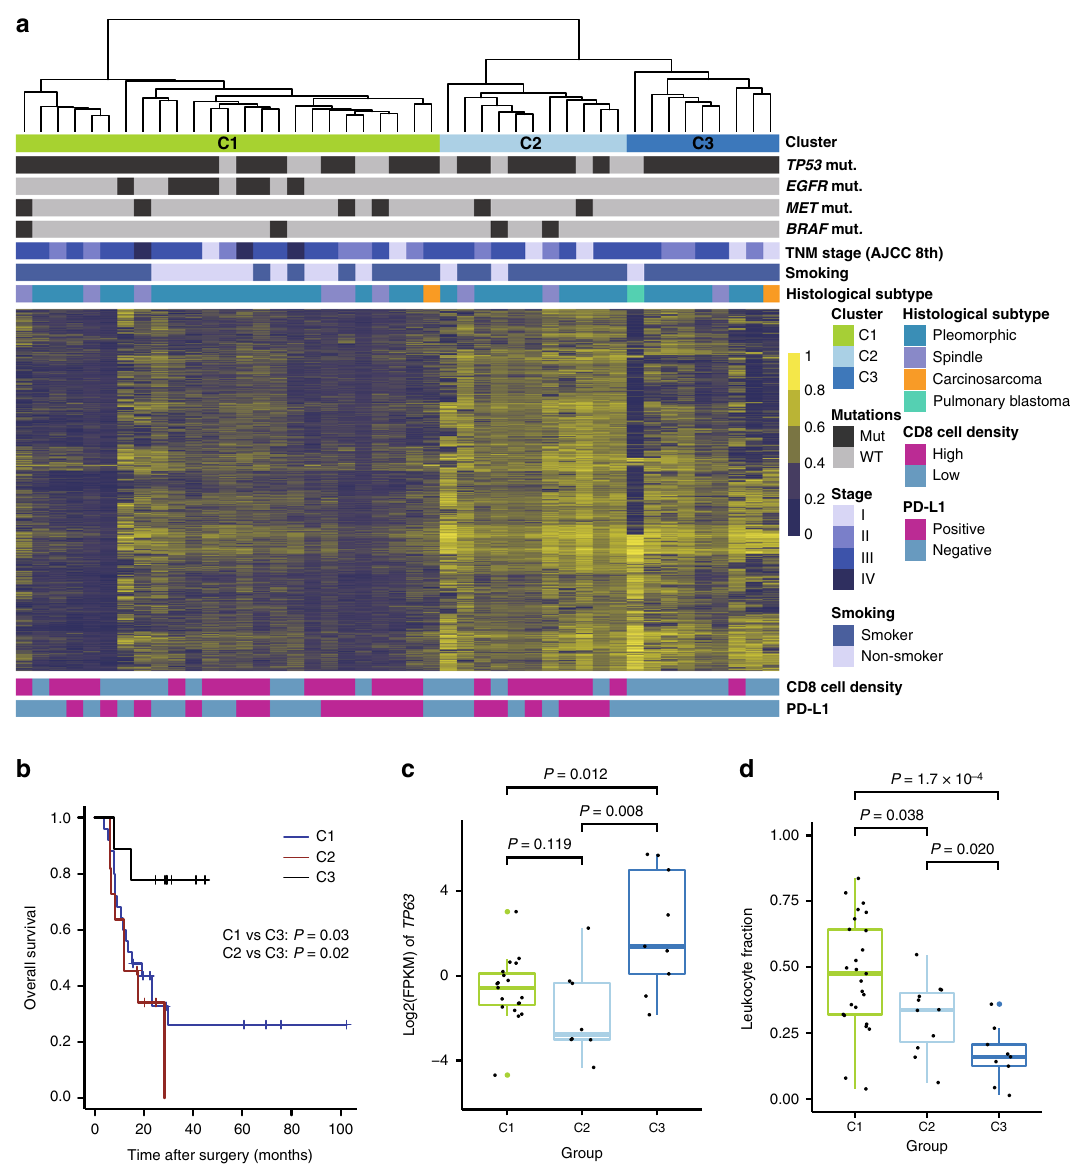
Fig. 5 Integrated molecular classi fi cation of PSC. a PSC tumors are classi fi ed into subgroups based on DNA methylation patterns, annotated for the mutation status (Mut, mutated; WT, wild-type) of important genes, TNM stage, smoking status, and histological subtype in the top panel and for the immunohistochemical analysis of PD-L1 and CD8 in the bottom panel. b Kaplan – Meier analysis of C1, C2, and C3. The signi fi cance is determined by log- rank test. c Boxplot shows the expression level of TP63 for three clusters. d Leukocyte fraction of each sample for three clusters are plotted as boxplots. Center line, median; box limits, upper and lower quartiles; whiskers, 1.5× interquartile range; colored points, outliers. Two-sided Wilcoxon rank-sum test was used for statistical analysis of ( c ) and ( d ). No P -value adjustment was applied. PD-L1, programmed death ligand 1; CD8, cluster of differentiation 8; TP63 , tumor protein